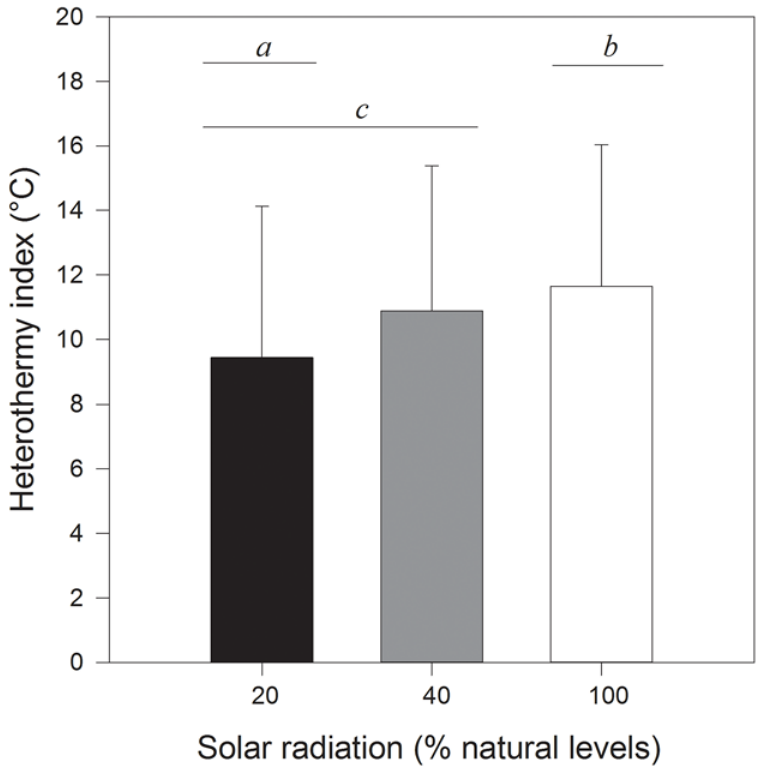
Fig 3. Overall mean heterothermy index [30]. Eastern rock elephant shrews ( Elephantulus myurus ) housed in outdoor cages with exposure to natural (100%) or experimentally reduced (approximately 20% or 40%) levels of solar